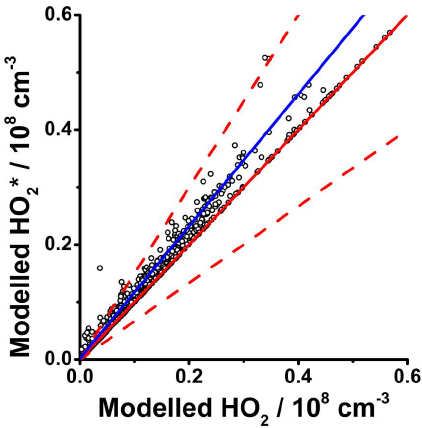
Figure A1: Comparison between modelled HO 2 * (the sum of HO 2 and potential RO 2 interferences) and modelled HO 2 for RONOCO. The solid red line indicates the 1:1 line, with 50 % limits given by the broken red lines. The best fit line is shown in blue and is described by HO 2 * = [1.15 × HO 2 ] + 2 × 10 5 cm -3 .